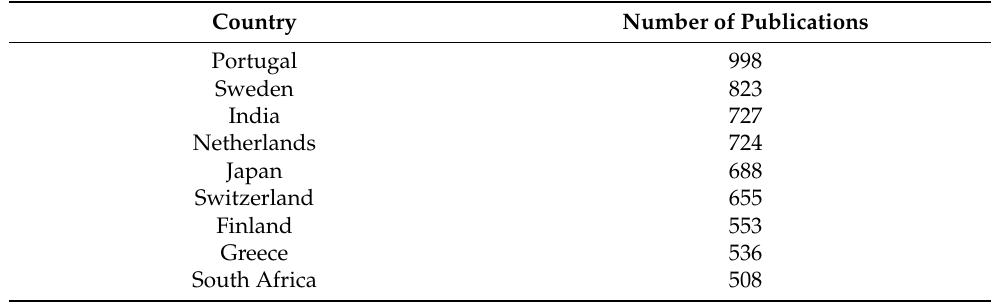
Table 4. Number of publications by countries which have publications between 500 and 999 (Group A countries).